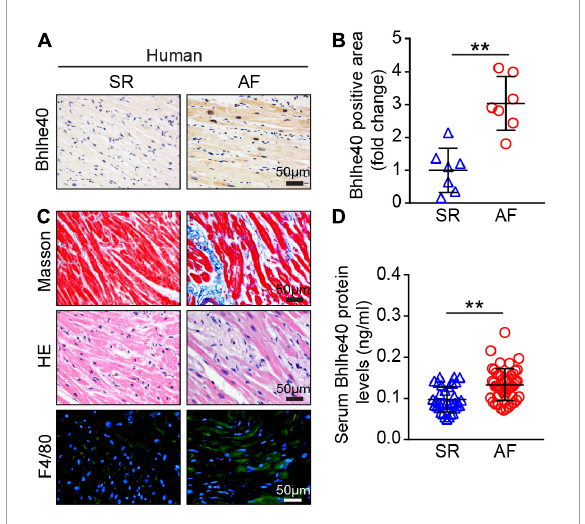
FIGURE1 Expression of Bhlhe40 was increased in patients with AF. (A,B) Immunohistochemical (IHC) staining of Bhlhe40 expression in atria from sinus rhythm (SR) controls and patients with AF (left), and quantification of the Bhlhe40-positive area (brown color; n = 7, left). Scale bar = 50 µ m. (C) Masson staining (upper) of atrial sections for examination of fibrosis (blue); H&E staining (middle) of atrial sections for detection of inflammatory cell infiltration (blue), and immunofluorescent staining (lower) of atrial sections for examination of F4/80-positive macrophages (green) and nuclei (DAPI, blue) ( n = 7). Scale bar = 50 µ m. (D) ELISA of the serum Bhlhe40 level from SR controls ( n = 35) and patients with AF ( n = 49). ** P < 0.01 vs normal SR controls.